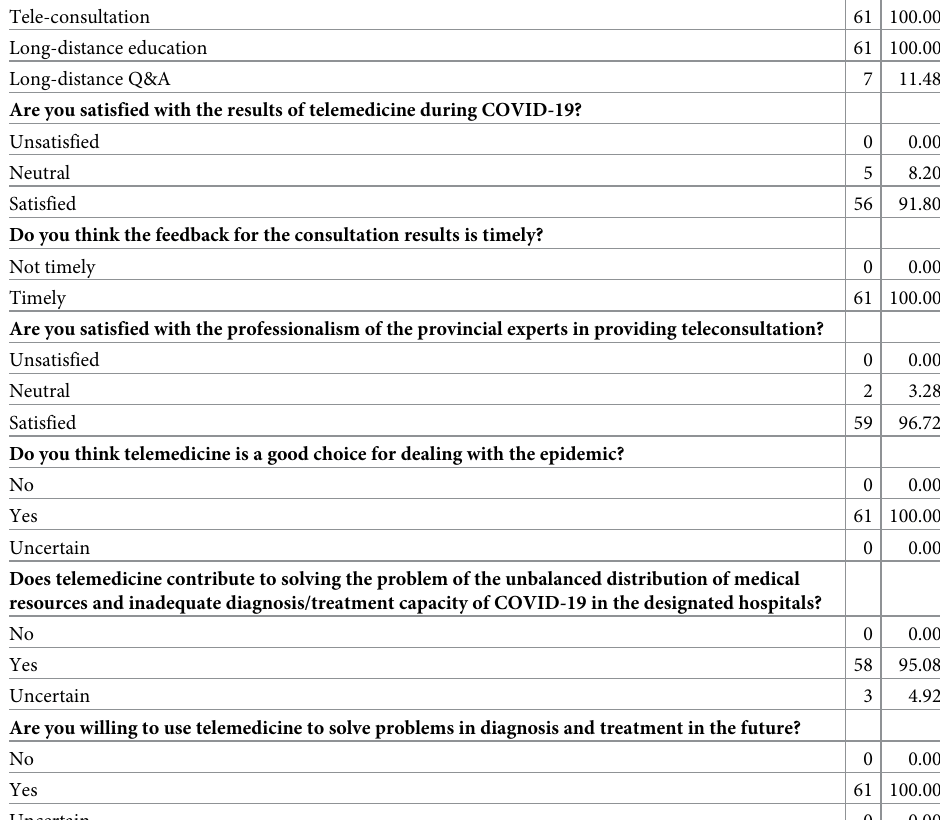
Table 7. The satisfaction survey of doctors in secondary hospitals who had experienced telemedicine in the COVID-19 epidemic ( n = 61). Items n % What types of telemedicine did you participate in during the COVID-19 epidemic? Tele-consultation 61 100.00 Long-distance education 61 100.00 Long-distance Q&A 7 11.48 Are you satisfied with the results of telemedicine during COVID-19? Unsatisfied